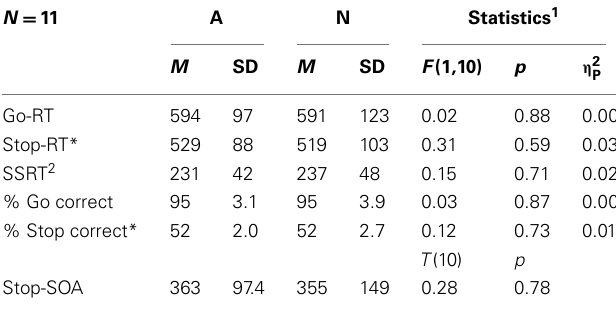
Table 4 | Stop-signal paradigm –ANOVA.